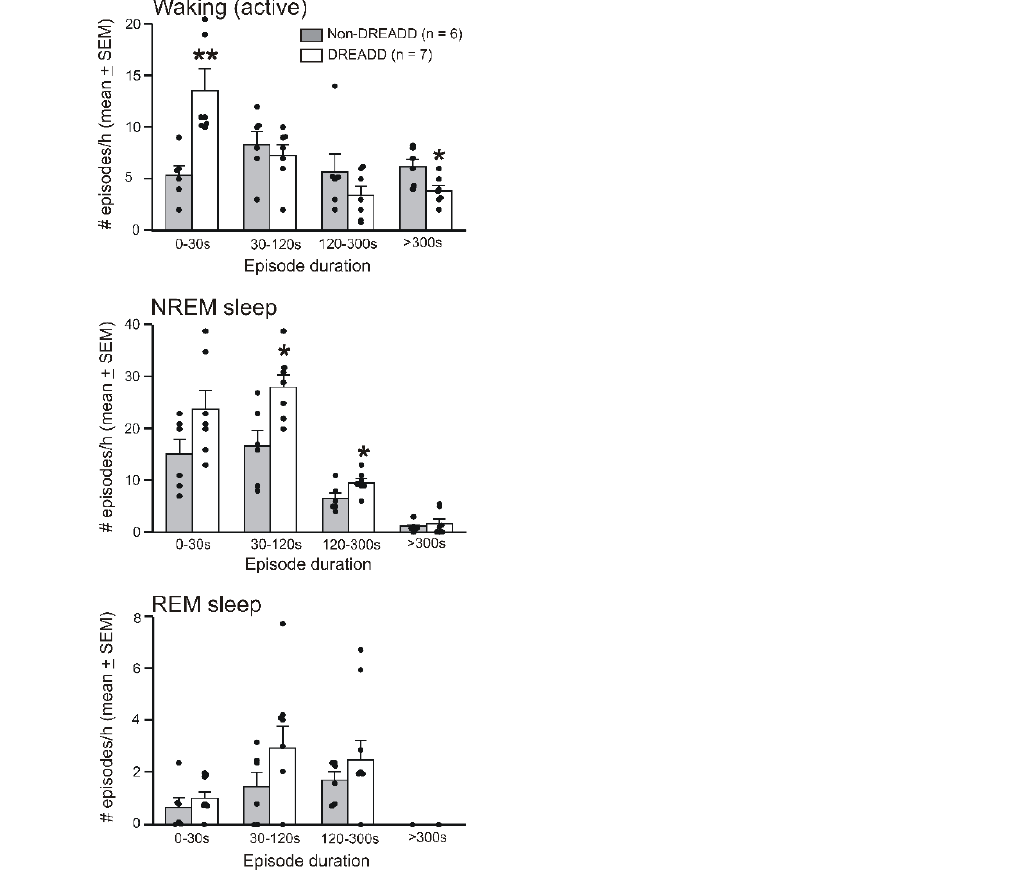
Figure 4. Effects of the chemoactivation of VLPO > PF-HA PRJ neurons on sleep–waking stability. The numbers of episodes of waking, nonREM sleep, and REM sleep of various durations exhibited by individual rats (filled circles) and as a group (mean ± SEM; bars) during the first 3 h after 1 mg/kg of CNO treatment in the non-DREADD and DREADD rats. Compared to the non-DREAD rats, the DREADD rats exhibited a decline in the number of longer bouts of waking, although the frequency of very short episodes of waking increased significantly. These rats also exhibited significant increases in short and medium bouts of nonREM sleep. REM sleep episodes were largely not affected. * p < 0.05; ** p < 0.01; independent t -test.